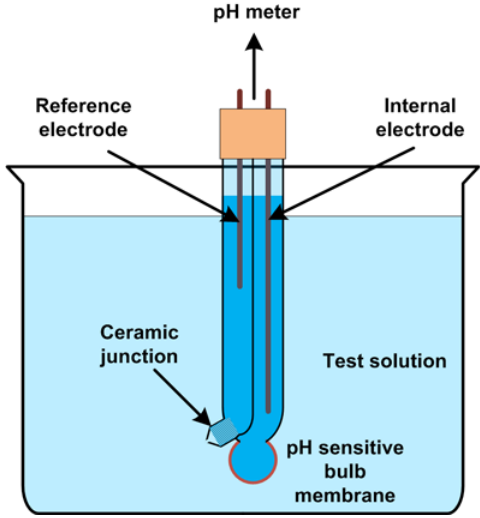
Figure 13. pH glass electrode in a test